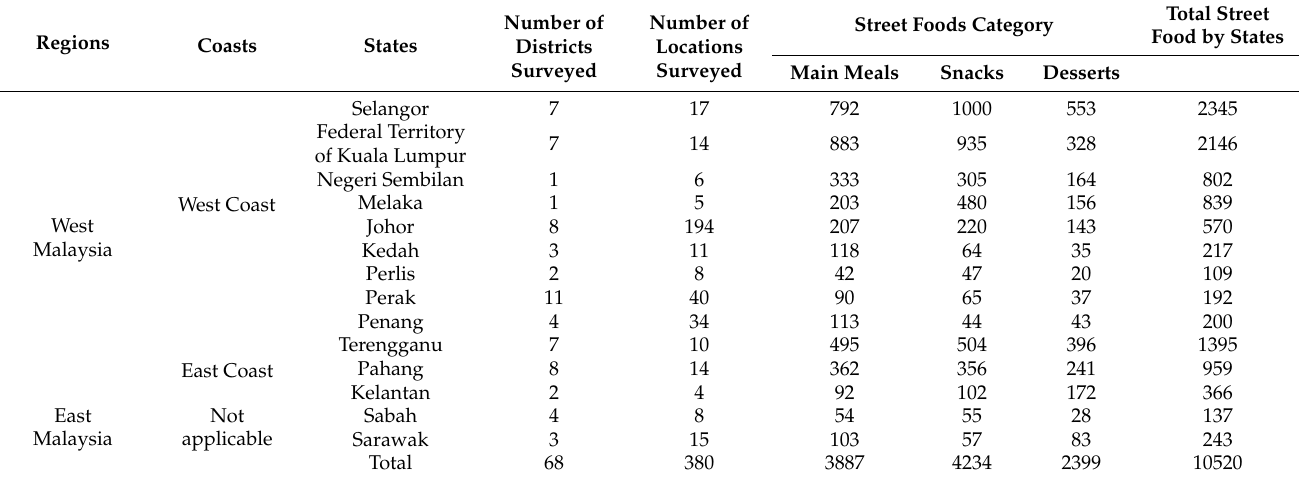
Table 1. The total number of street foods surveyed in this study by food category, districts, and locations of every